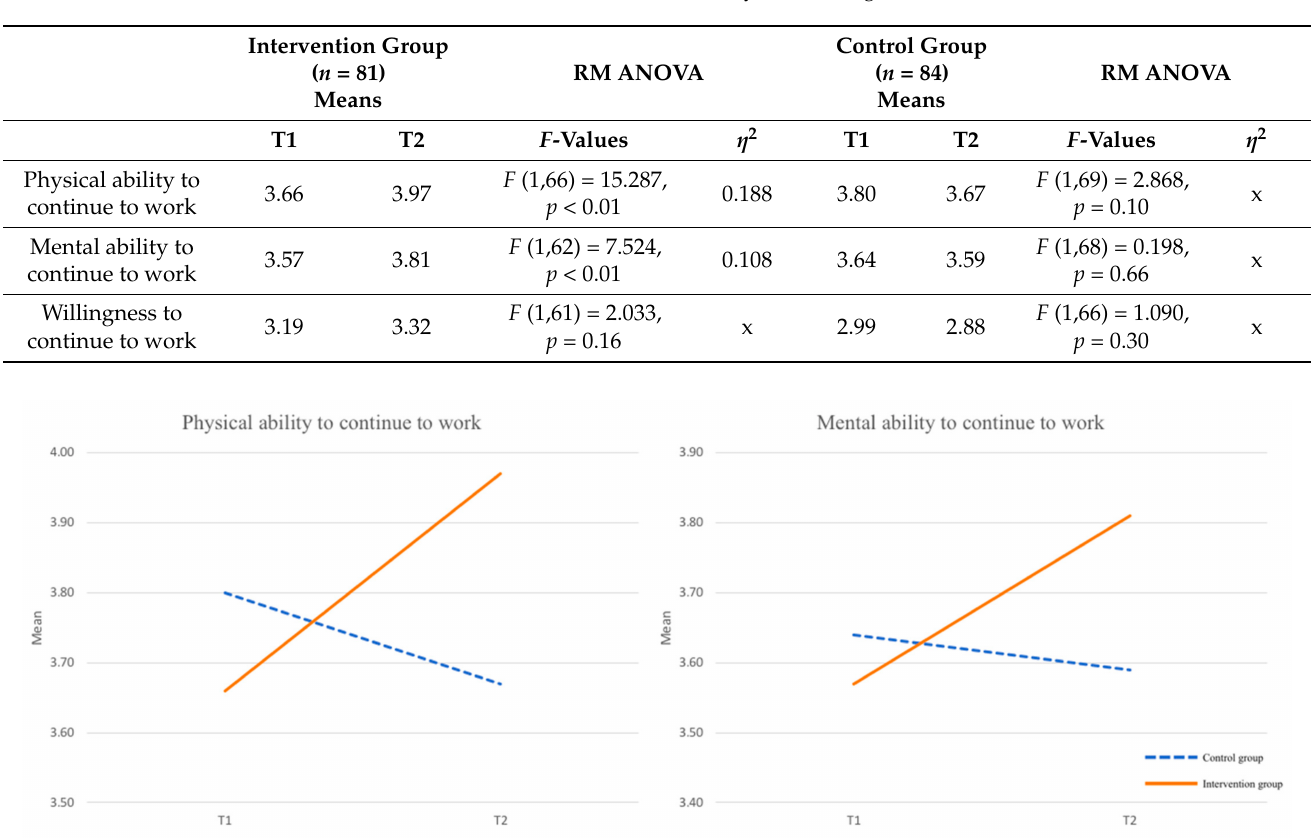
Table 2. Results of RM ANOVAs for ability and willingness to continue to work.